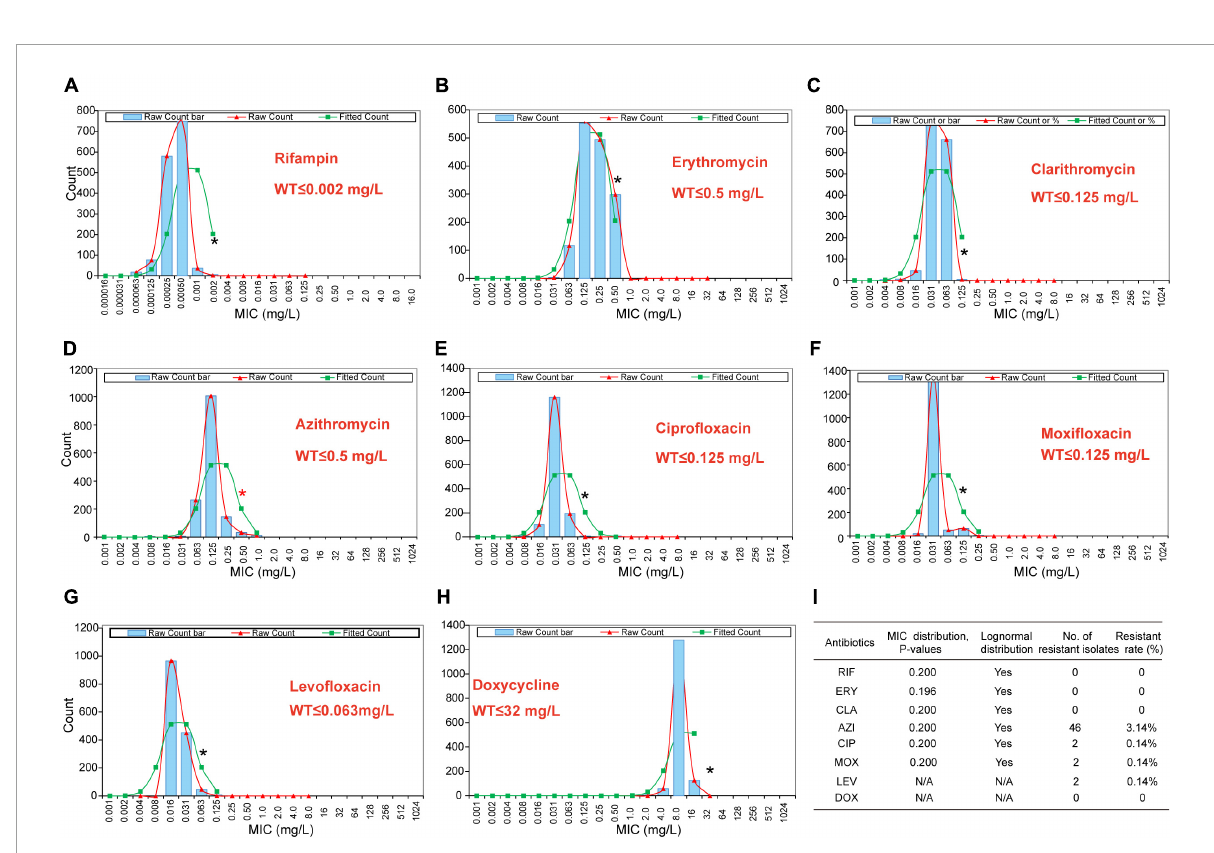
FIGURE4 Wild-type cutoff (COWT) of the eight antibiotics against L. pneumophila using the ECOFFinder method. (A–H) MIC distributions of the eight antibiotics, fitted curves, and ECOFF were obtained by the ECOFFinder. (I) Relevant data table obtained by the ECOFFinder. Asterisks indicate the possible largest WT